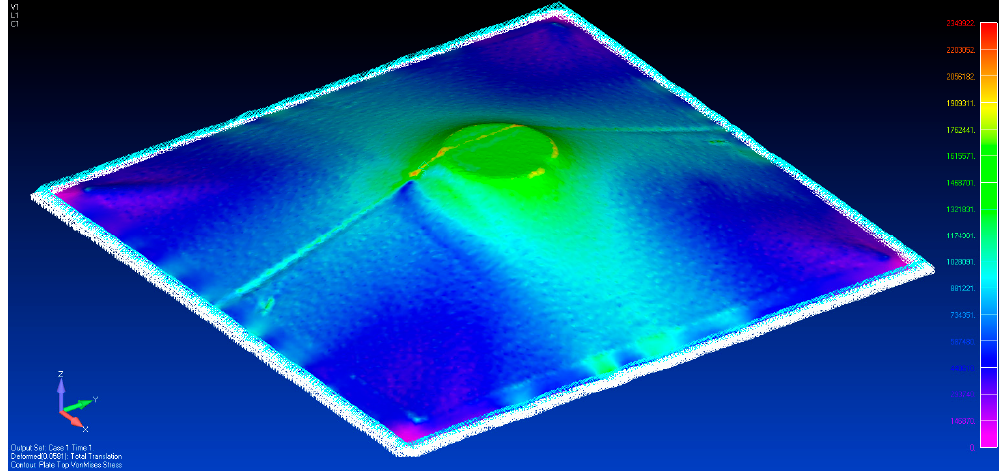
Figure 21. The von Mises stress distribution with three spacers placed beneath the membrane.